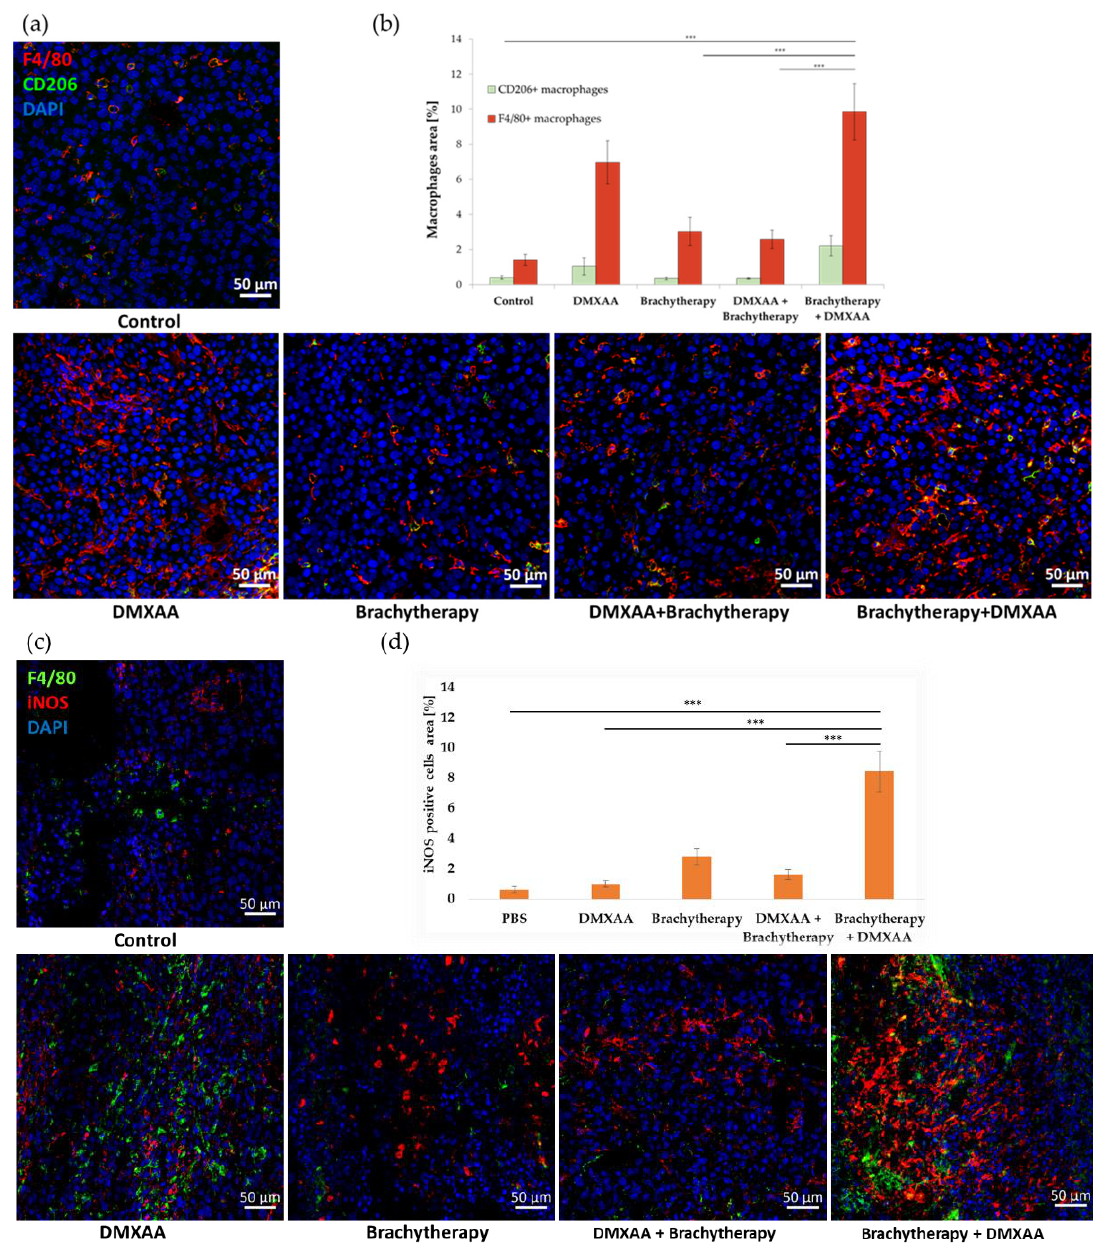
Figure 4. Effect of therapy on infiltration of tumors by macrophages. Twenty days after tumor inoculation tumors were collected. ( a ) Tumor sections were stained with anti-F4/80 and anti-CD206 antibodies. F4/80 positive total macrophages (Alexa Fluor 594, red), CD206 positive M2 macrophages (FITC, green) and nuclei (DAPI, blue) were visualized using confocal microscope. Photographs were taken in 5 randomly chosen fields (magn. 20 × ) per section in at least 4 tumors of each group. Representative photographs are shown. ( b ) Percentage of the area covered by selected populations of macrophages was calculated (mean ± SEM) *** p < 0.001 Kruskal–Wallis multiple comparisons. ( c ) M1 macrophages were stained using anti-iNOS antibody. F4/80 positive total macrophages (AlexaFluor488, green), iNOS positive M1 macrophages (TexasRed, red) and nuclei (DAPI, blue) were visualized using confocal microscope. Representative photographs are shown. ( d ) Percentage of the area covered by iNOS positive cells was calculated (mean ± SEM) *** p < 0.001 Kruskal–Wallis multiple